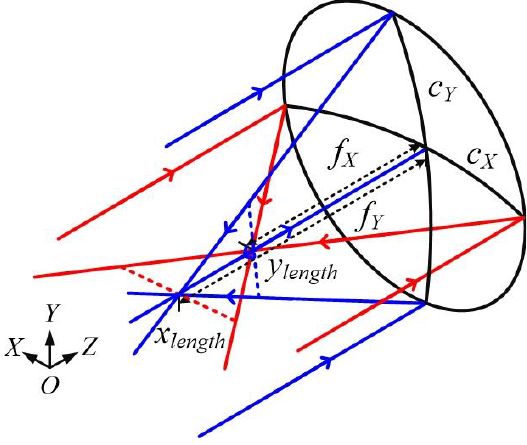
Figure 1. Surface map of an anamorphic surface.